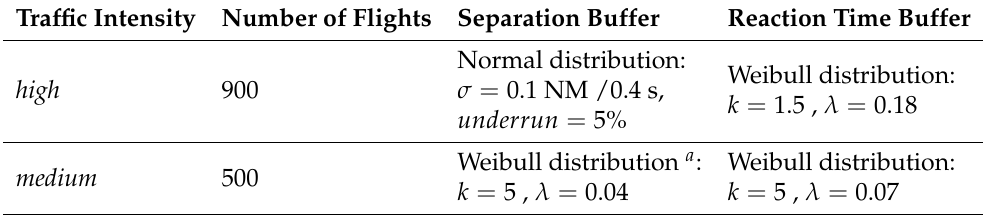
Table 1. Chosen distributions and parameters for the generation of air traffic flight